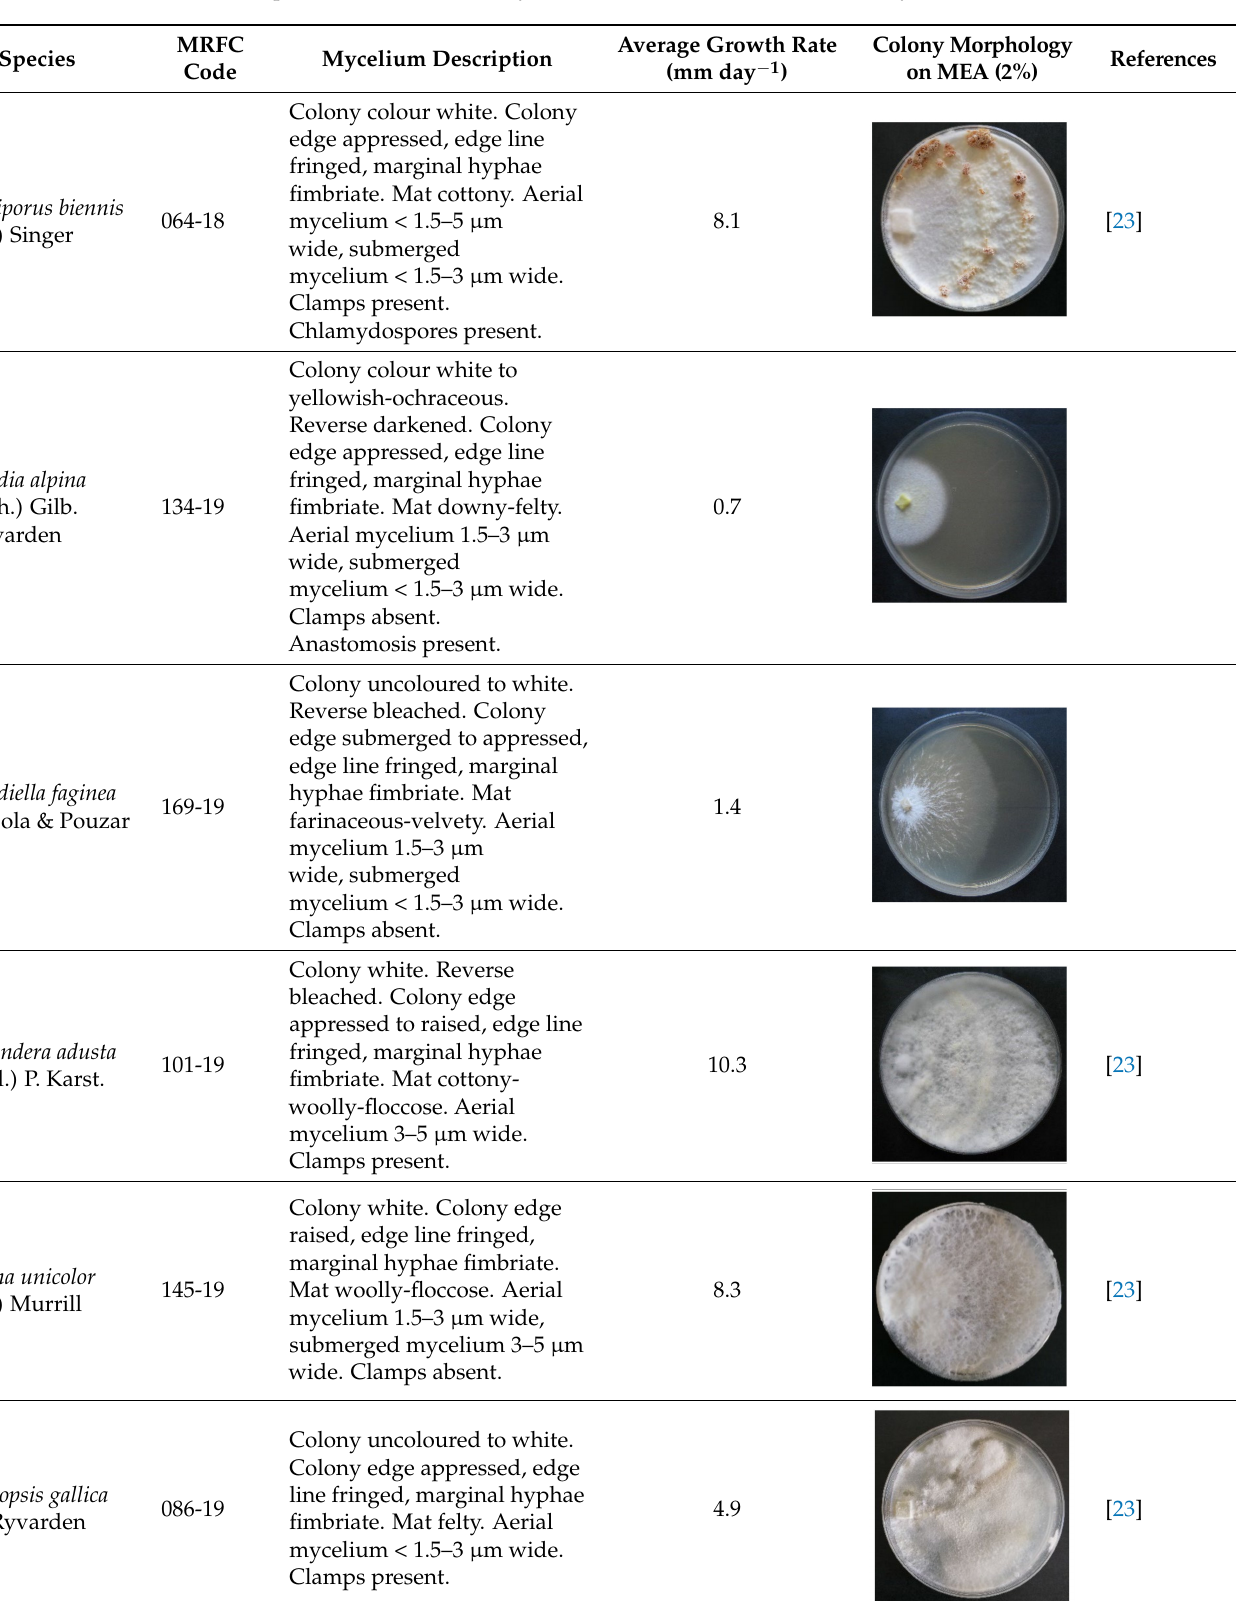
Table 3. Morphological description of the strains in pure culture and the average growth rate of the